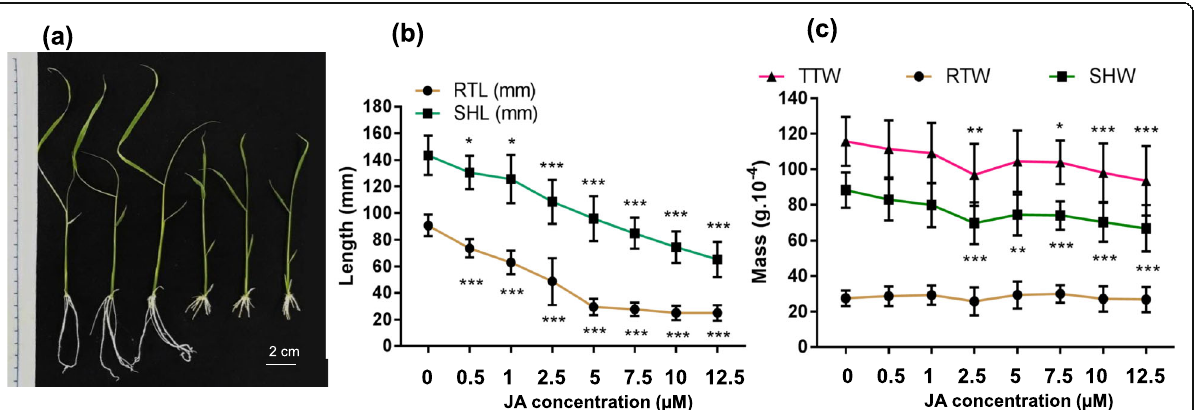
Fig. 1 Effect of the JA concentration on rice plantlets (IR64) development. Five parameters were collected from 7 day-old plantlets after JA treatment and growth in 1/2 MS with or without JA. Phenotype of the plantlet IR64 ( a ), plants on 0 μ M medium were on the left, plants on 5 μ M medium were on the right; Data represent means of three biological replicates (±SD) of root and SHL ( b ); TTW- RTW and SHW ( c ) from 15 to 17 plantlets of each condition. Student ’ s t- test was used to assess the differences between the plant grown under untreated condition (0 μ M) versus under different concentration of JA. The significant is shown with p -values: (*) p < 0.05, (**) p < 0.01, (***) p <